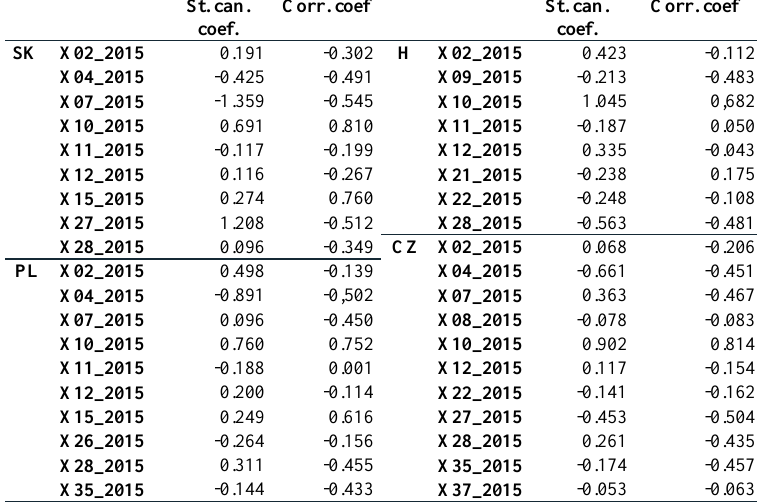
Table 5. Standardized canonical discriminant function coefficients and correlation